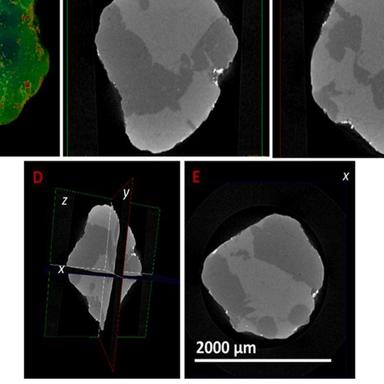
μ-XRF elemental maps of a soil particle from the Bolladalen site. The XRF lines of La-L, Pr-L and Nd-L are strongly overlapped with Ce-L. Map size: 1650 � 900 μm2, 50 μm step size, 1 s/pixel.